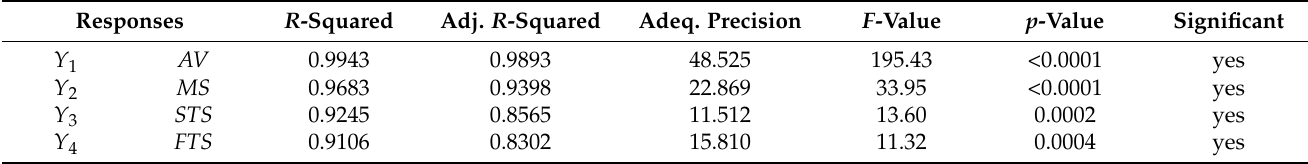
Table 8. ANOVA results for quadratic model of APCRA.